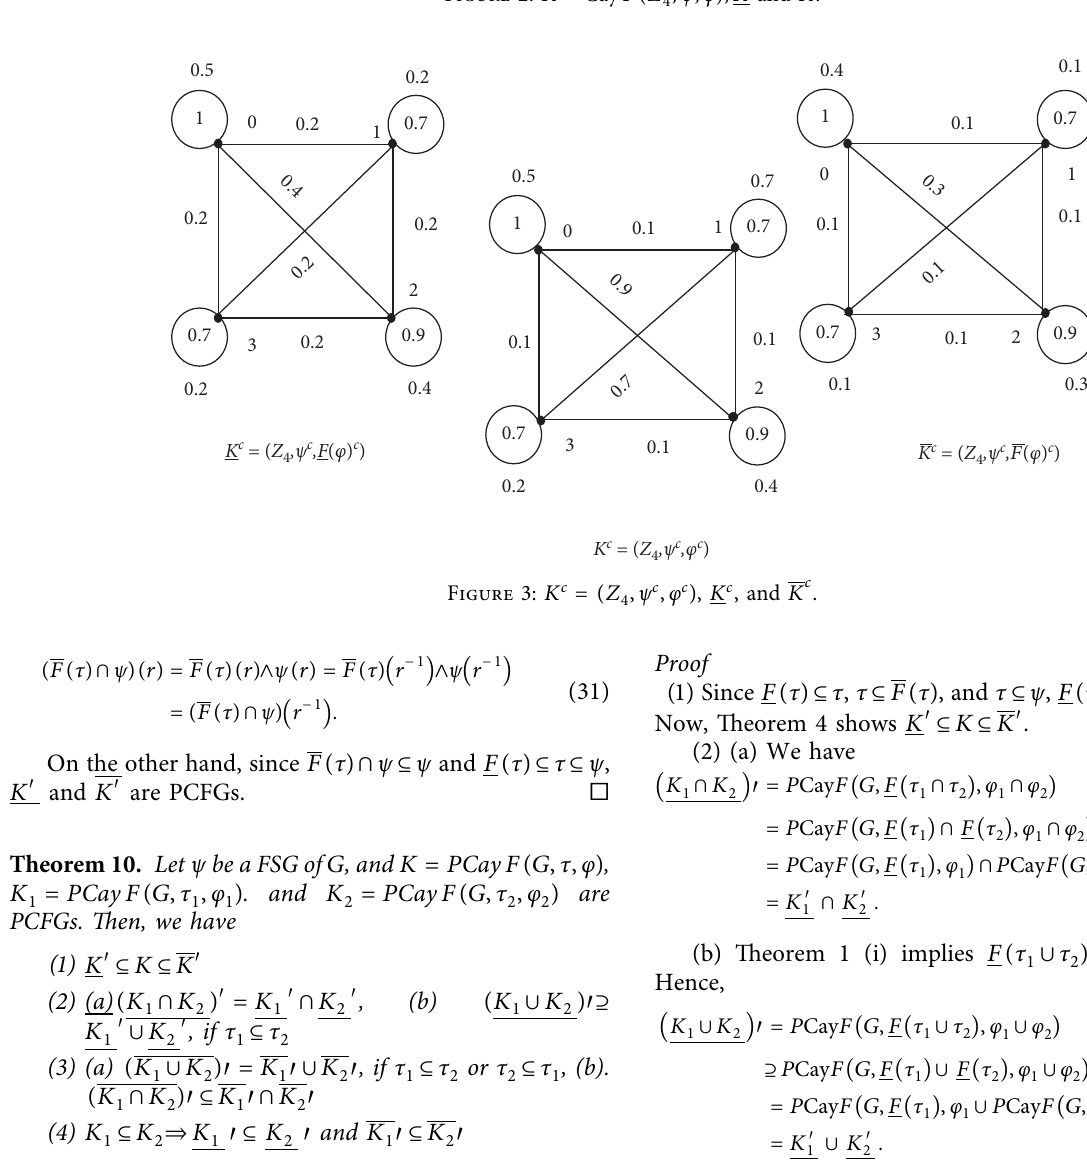
Figure 2: K � Cay F ( Z